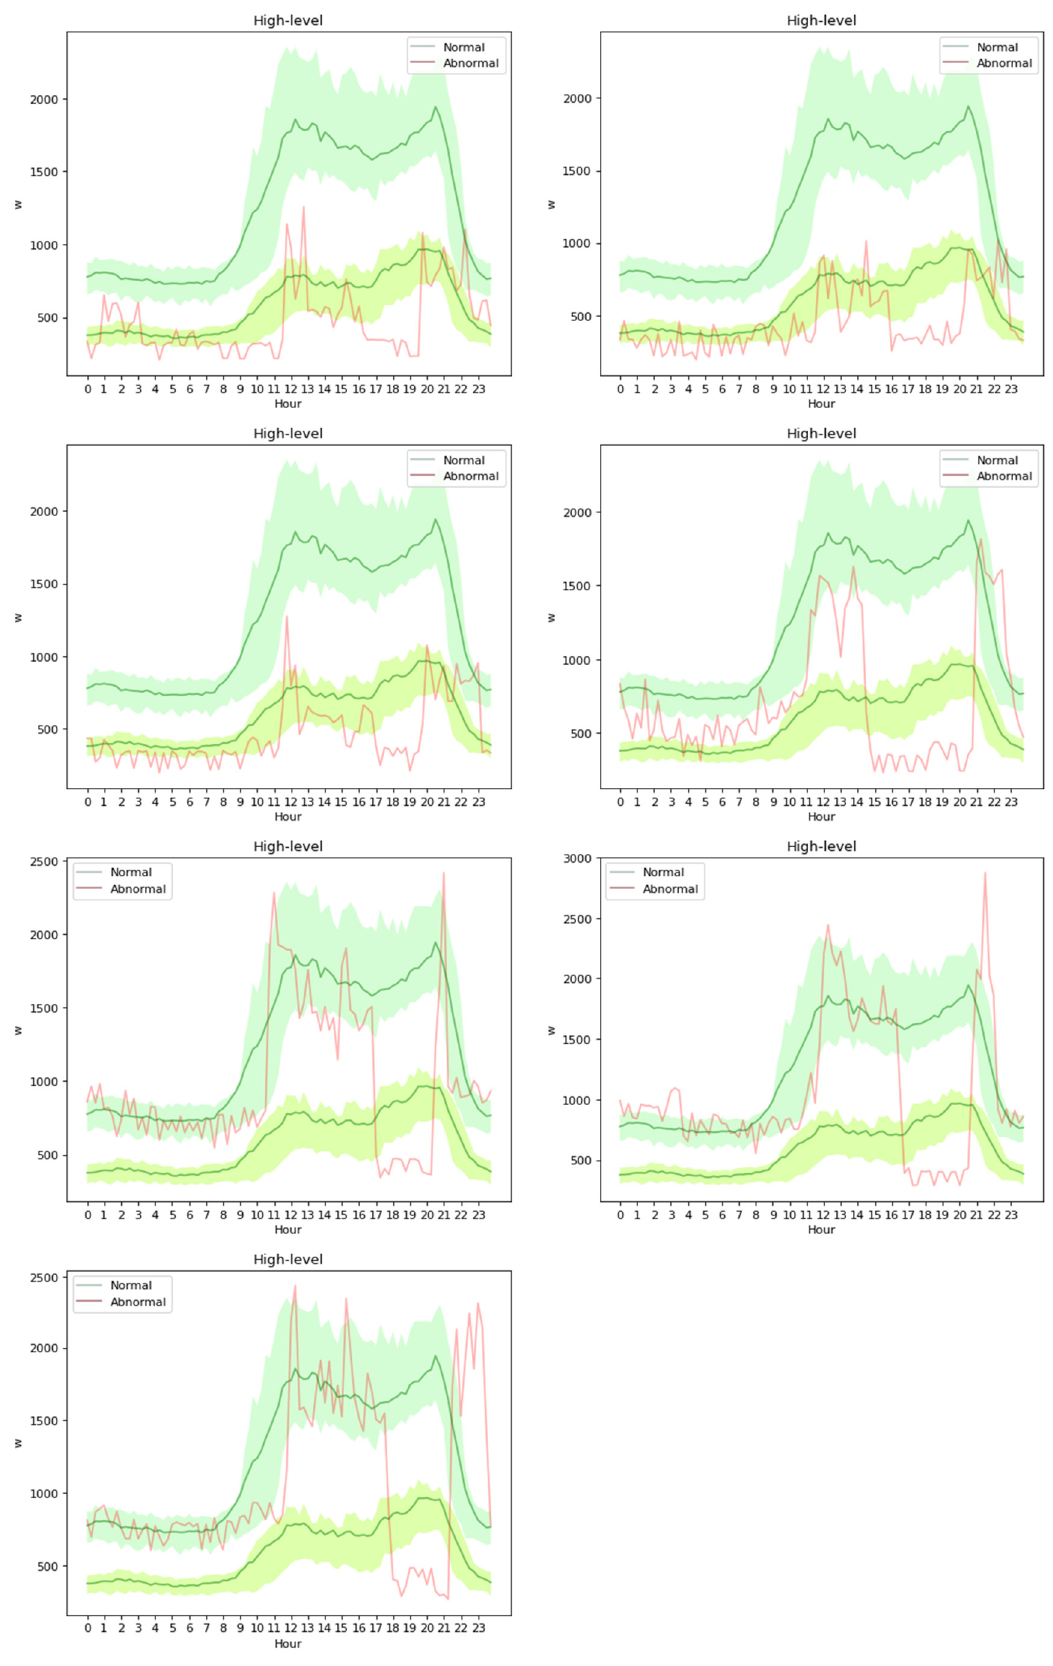
Figure A10. Load profiles of each abnormal electricity consumption events of User 05 using the high-level features.